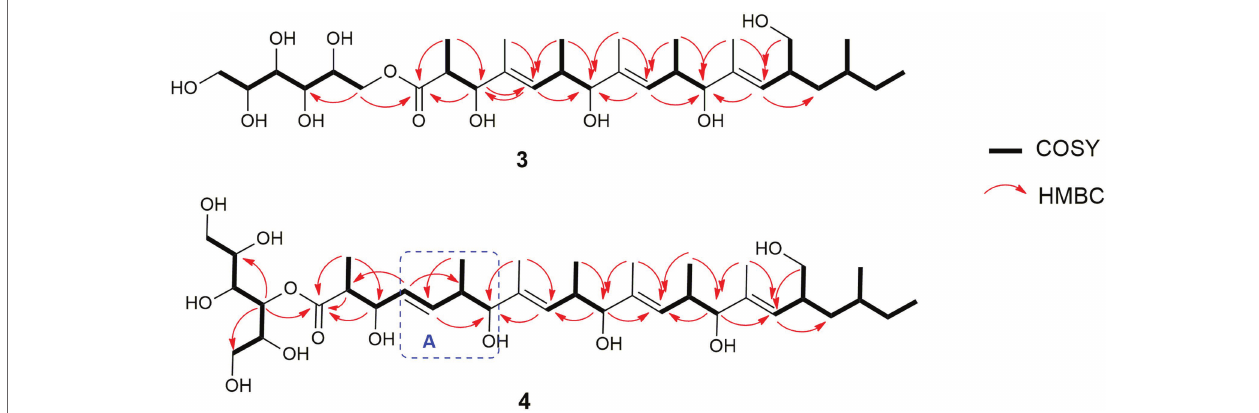
FIGURE 8 | Selected COSY and HMBC correlations of muyocopronol A ( 3 ) and muyocopronol B ( 4 ).